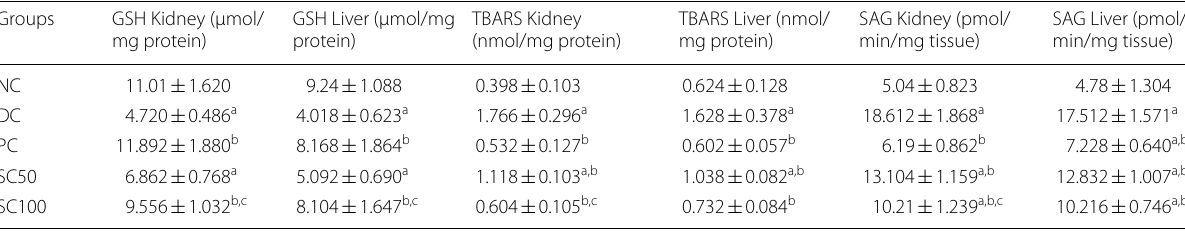
Data are expressed as mean S.D. (n 5). NC: normal healthy control; DC: diabetic control; PC: positive control (STZ induced diabetic rats treated with reference drug ± = acarbose (60 mg/kg body weight)); SC50 and SC100: STZ induced diabetic rats treated with S. commune extract (50 and 100 mg/kg body weight respectively) a P < 0.05 Different control groups when compared with normal group b P < 0.05 Diabetic control group when compared with other treated groups c P < 0.05 S. commune extract treated groups when compared with each